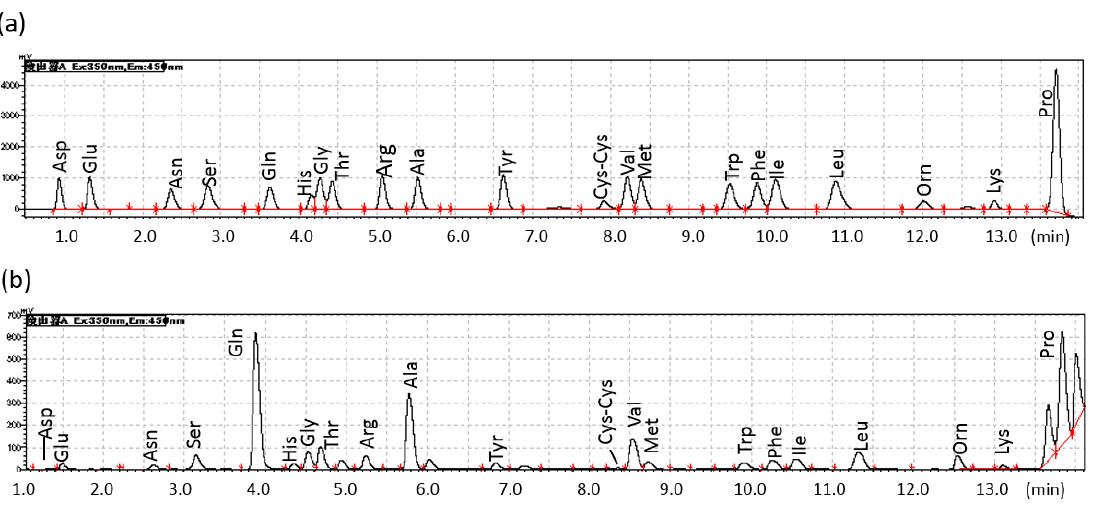
Figure 2. Representative chromatograms of ( a ) an AA standard and ( b ) a canine plasma sample. The concentration of AAs in the standard solution is 250 µ mol/L.